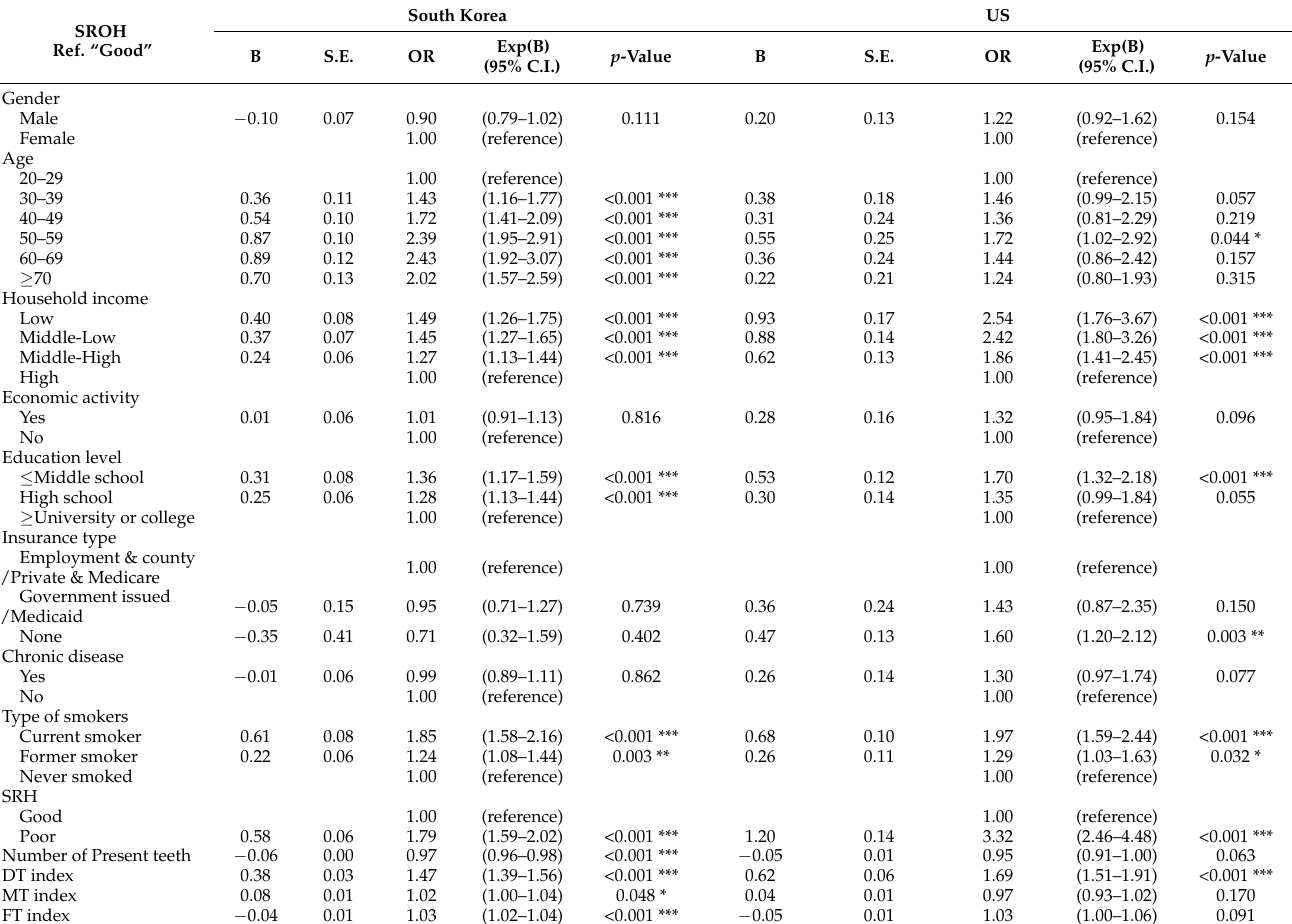
Table 3. Factors influencing the